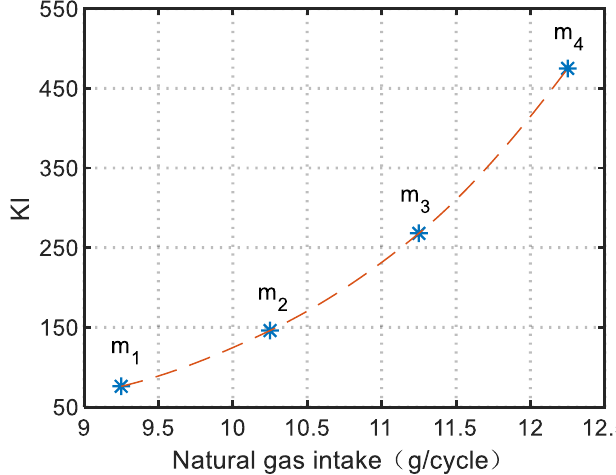
Figure 13. Knock intensity under different natural gas intake.